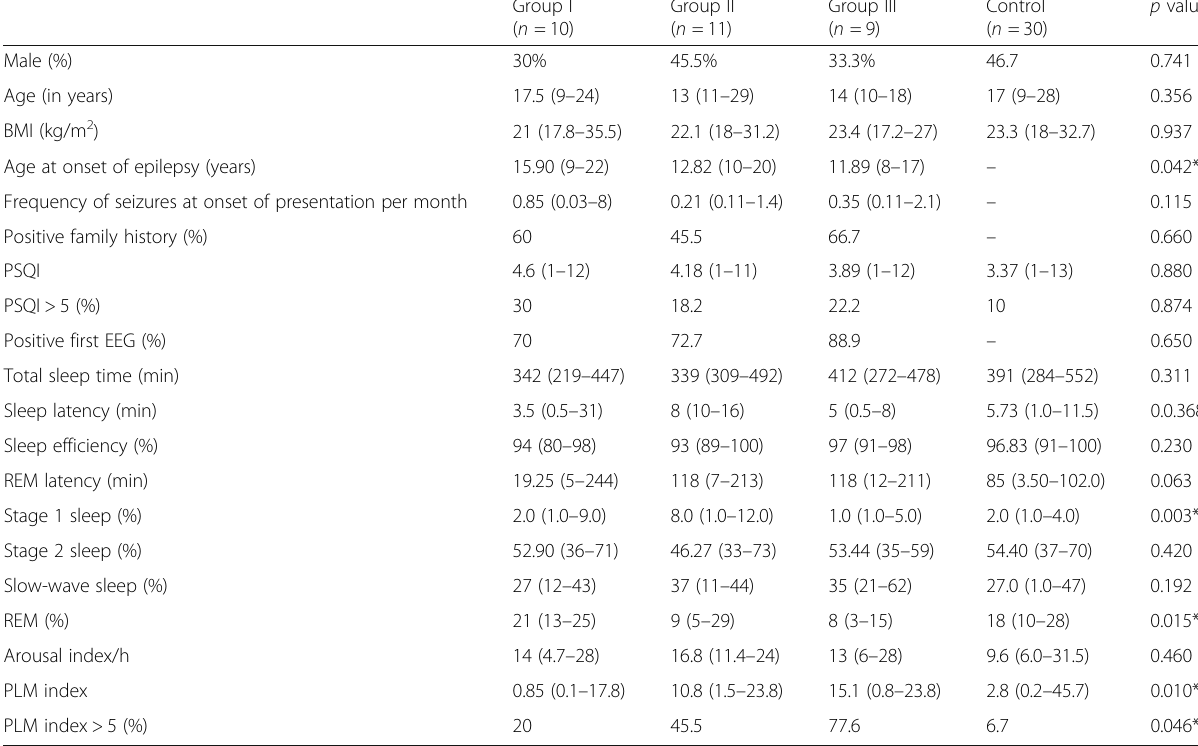
Table 1 Comparing demographic and sleep parameters among patients and controls